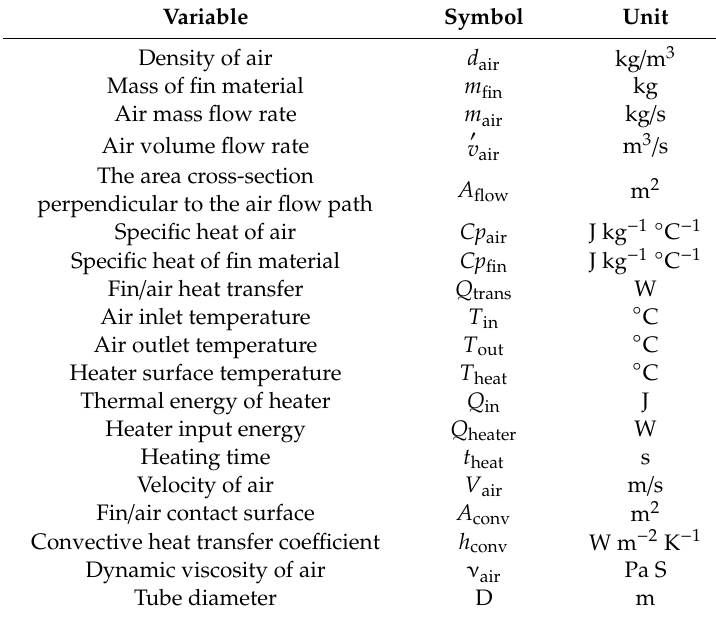
Table 2. The descriptions of the considered variables in heat